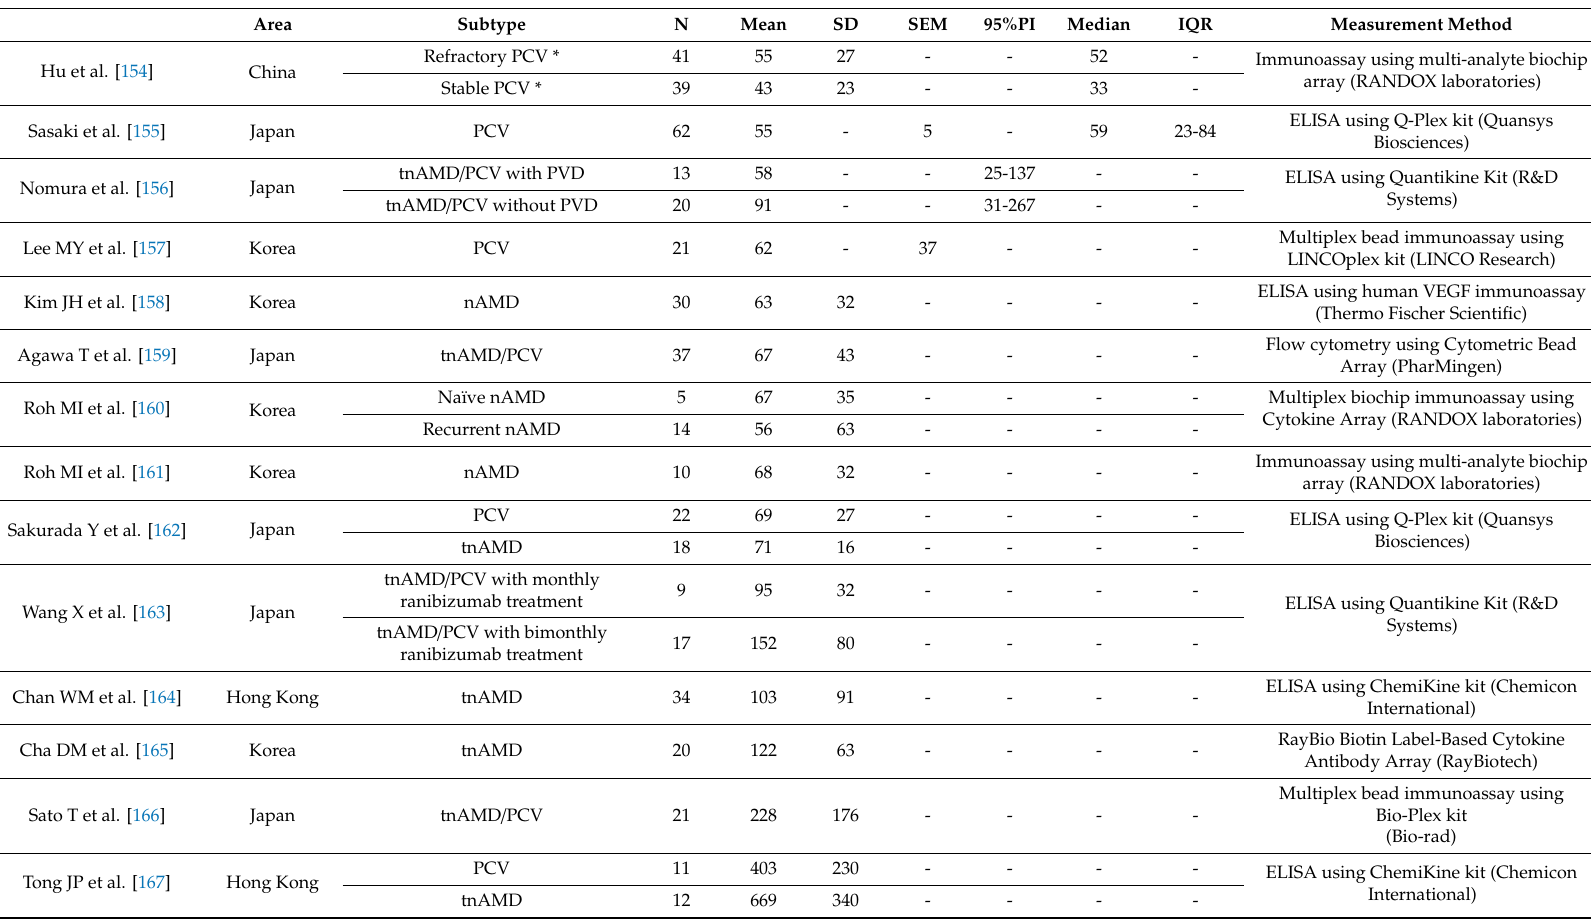
Table 4. Previously reported VEGF concentration (pg / mL) in aqueous humor of eyes with age-related macular